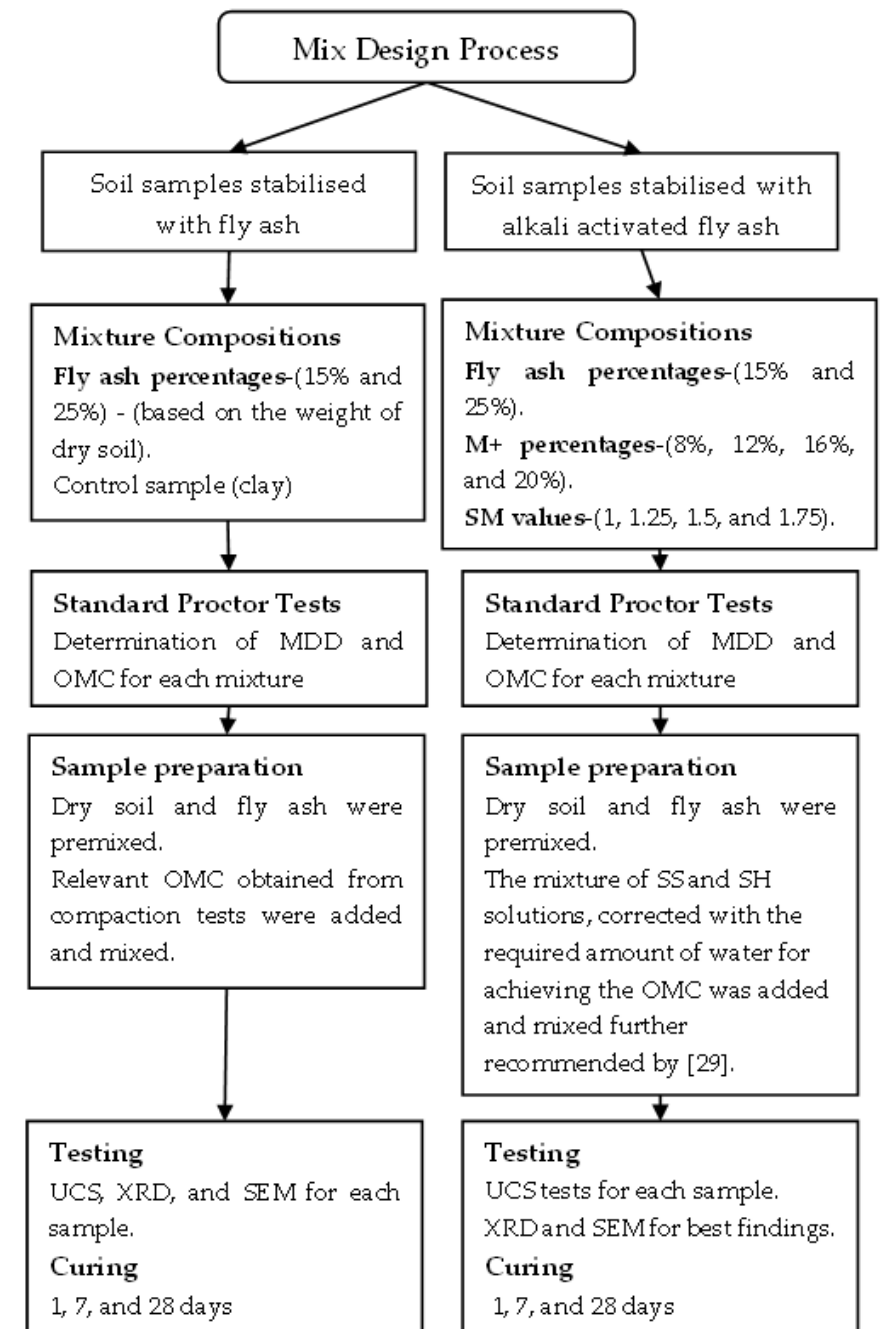
Figure 3. Flow chart of the mix design process.